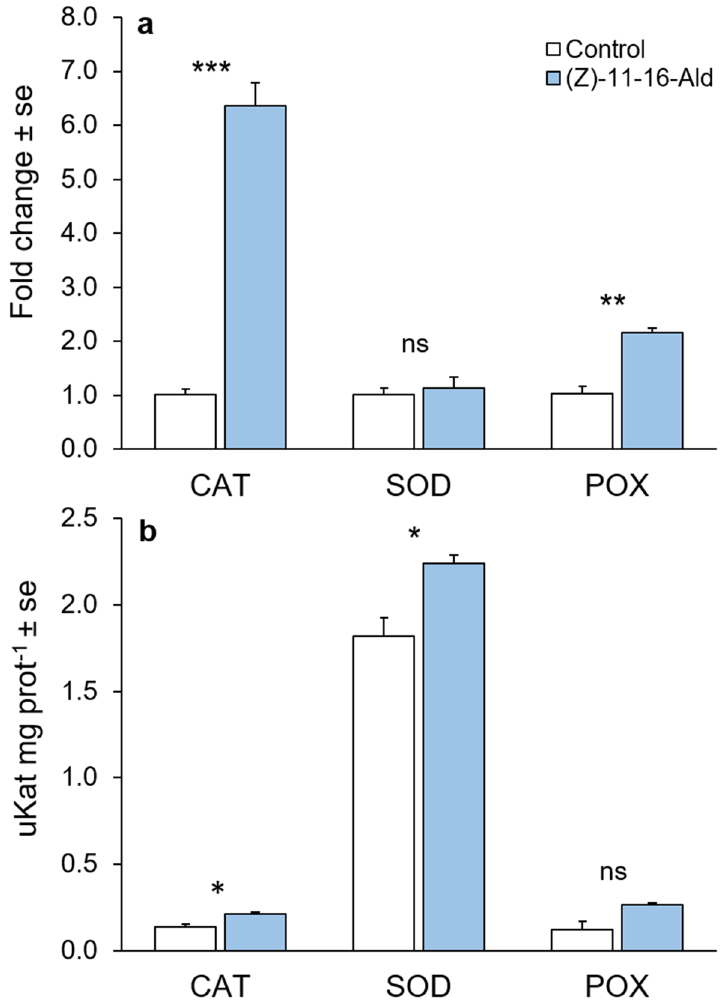
Figure 7. Gene expression ( a ) and enzyme activity ( b ) of three ROS-scavenging enzymes. Quantitative gene expression and enzyme activity were assessed after 30 min of exposure of plants to 100 ppm of ( Z )-11-16:Ald in solution of MES buffer + 0.1% Tween 20 or exposure to a solution of MES buffer + 0.1% Tween 20 as control. Error bars indicate se. * P < 0.05, ** P < 0.01, *** P < 0.001. ns indicates non-significant. n = 3 to 4 for each